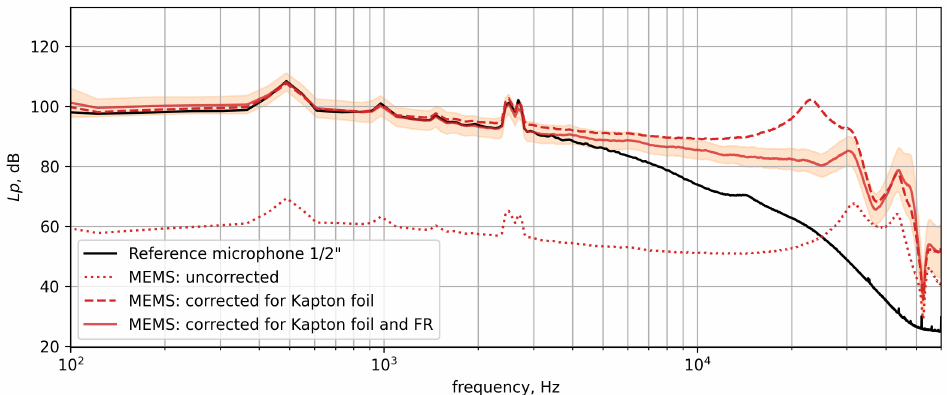
Figure 11. Comparison of the MEMS microphone spectrum and the reference microphone spectrum in the TWG at a Mach number of 0.3. The orange envelope illustrates the combined error margin obtained from the Kapton foil and frequency response